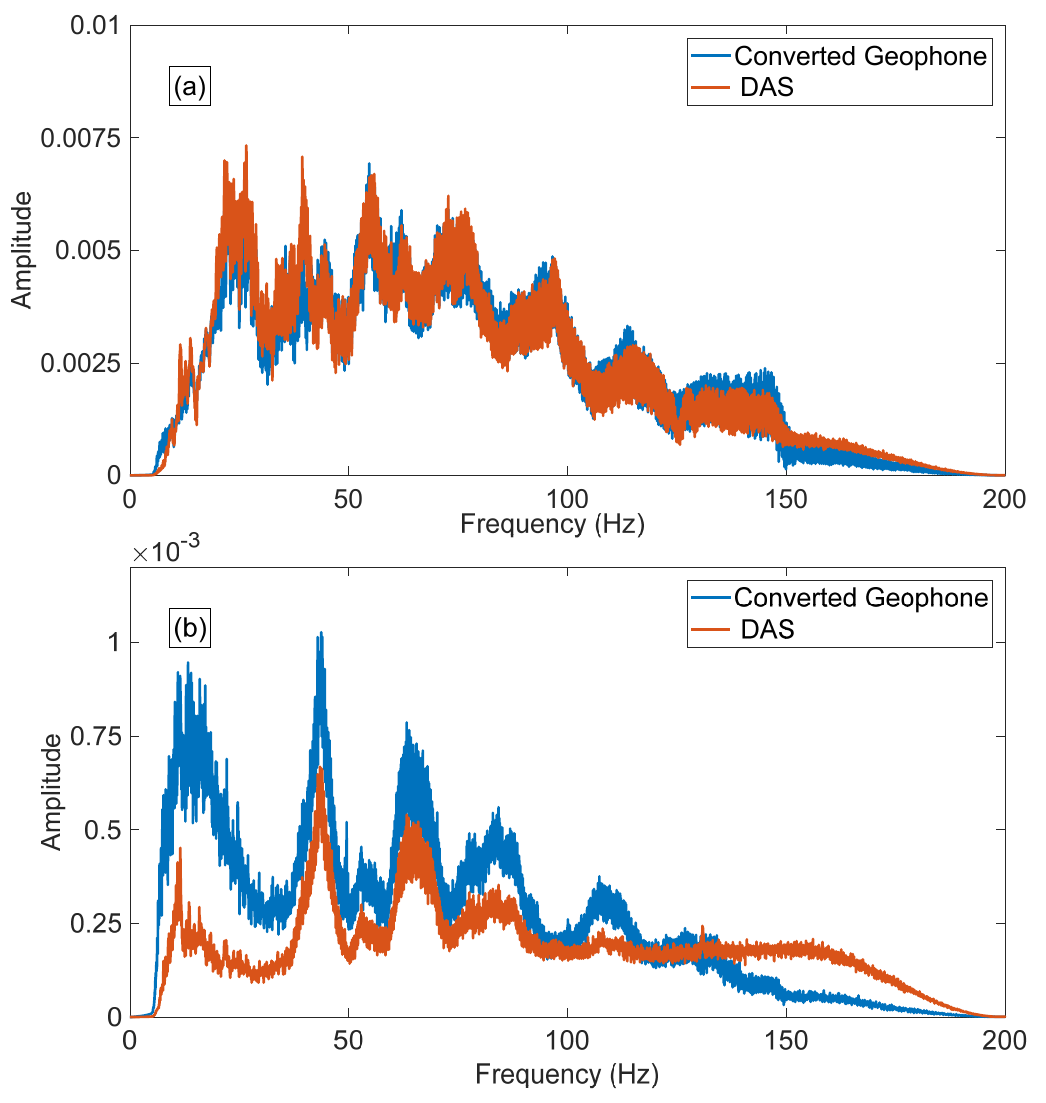
Figure 6. Amplitude spectrum comparisons for near ( a ) and far ( b ) offsets. The blue line is the strain rate from converted geophone, and the red line is the strain rate from DAS.